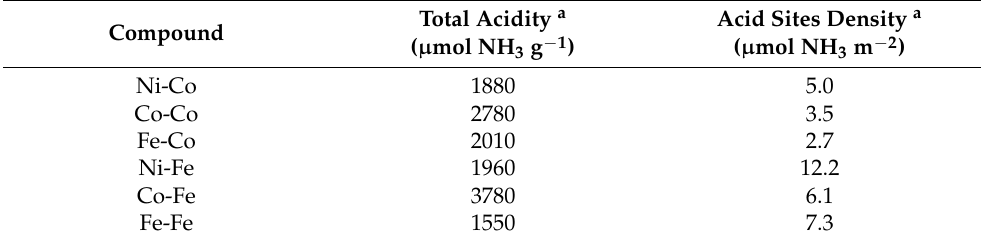
Table 8. Acid properties of the studied hexacyanometallates(III).